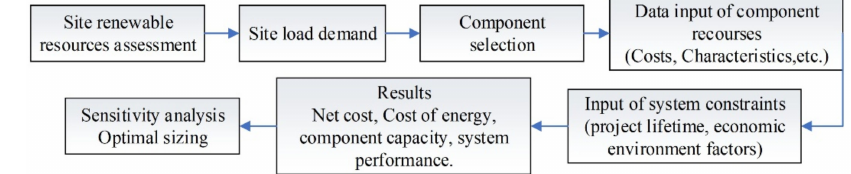
Figure 5. Detailed steps of HOMER used for studying optimal sizing analysis.